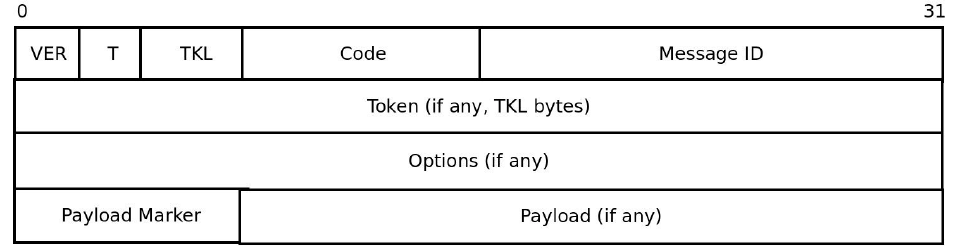
Figure 2. CoAP Header. Figure 2. CoAP